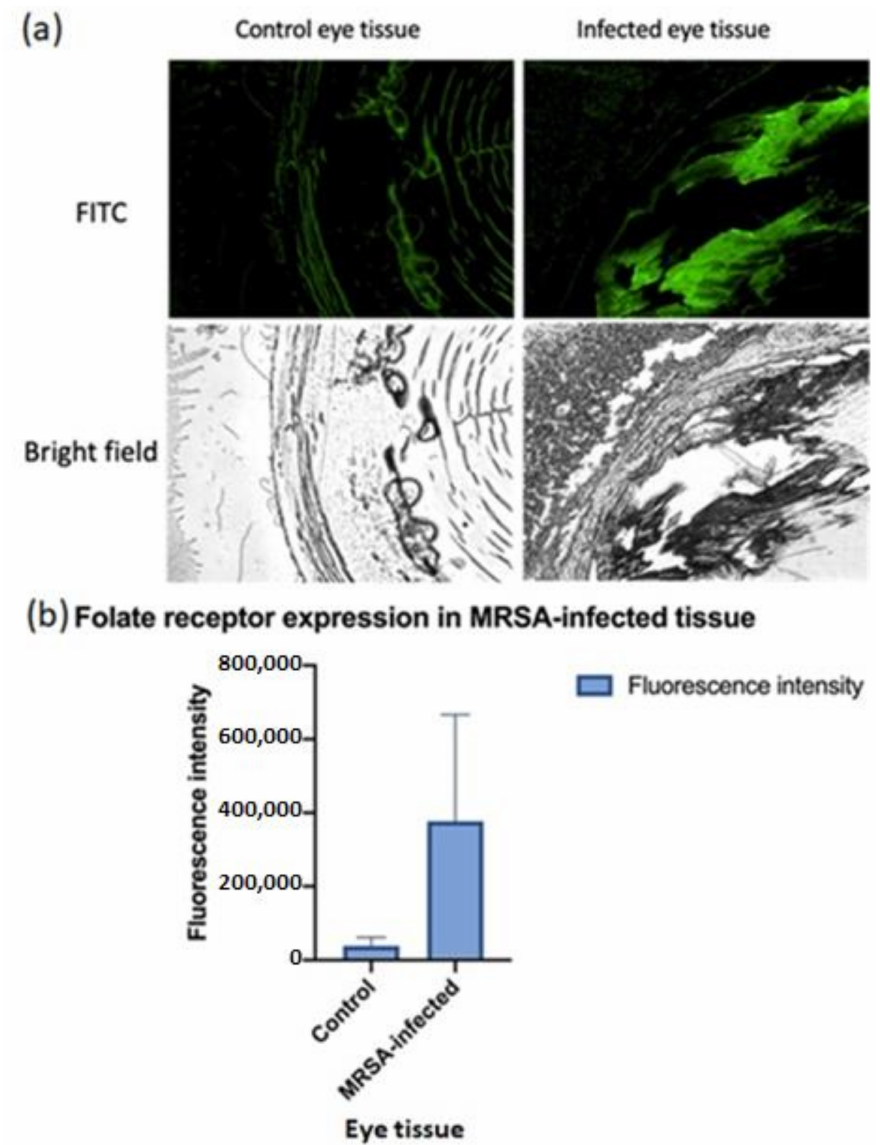
Figure 1. ( a ) Folate expression in MRSA infected tissue. A fluorescent microscopy study showed an overexpression of folate receptor (FR) in MRSA infected tissue in comparison to healthy tissue control. ( b ) The quantification of the folate expression data is shown ( n = 3). The significantly higher fluorescence intensity of FR in MRSA-infected tissues as compared to healthy tissues builds a strong rationale for developing FR-receptor homing nano-antibiotics for targeted MRSA